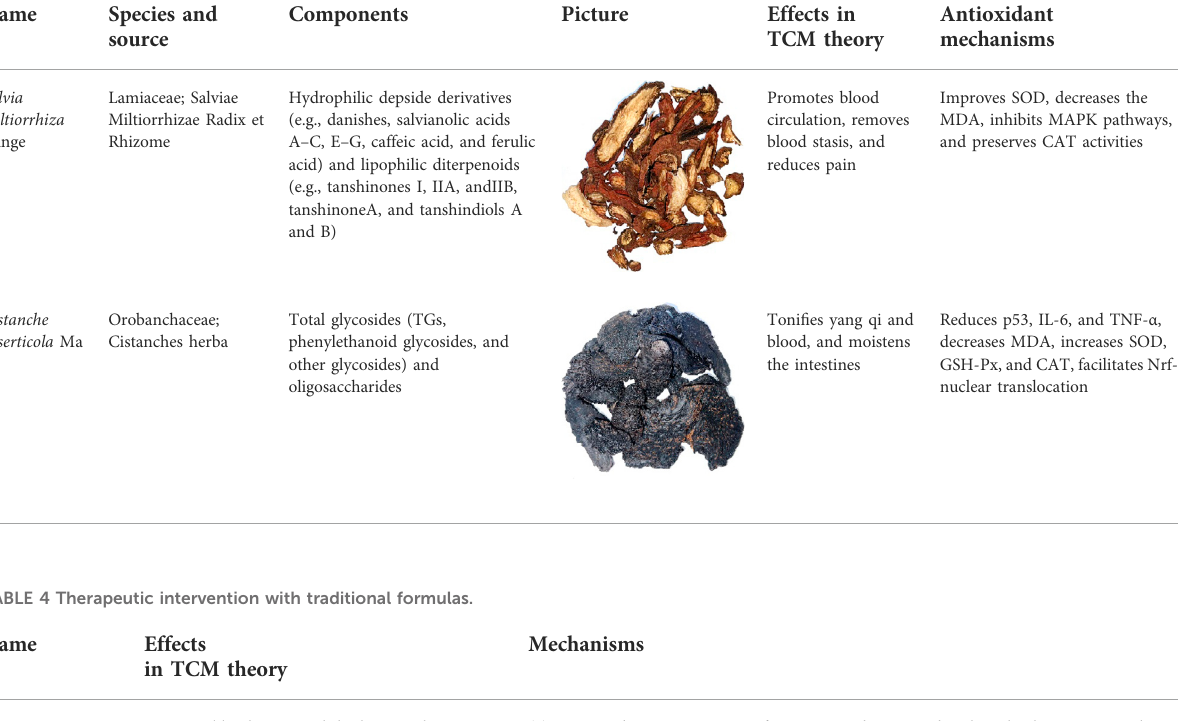
TABLE 3 Therapeutic intervention with Chinese herbs. Chinese herbs